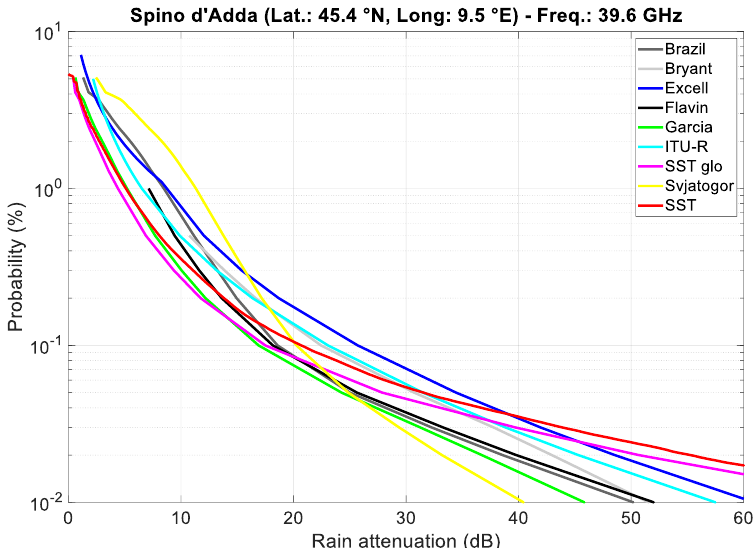
Figure 1. Annual probability distributions (%) of rain attenuation exceeded in the slant path at Spino d’Adda to a geostationary satellite (elevation angle 37.7°) on the meridian, at 39.6 GHz and a circular polarization, calculated by the indicated prediction models, using, as input, the rain rate probability distribution recorded locally, with rain rate expressed in millimeters per hour, in the years 1993 − 2002. The solid red line refers to using the full SST [17], whose input is the full set of rain rate time series recorded in the same period of time, whose probability distribution is used as input to the models.